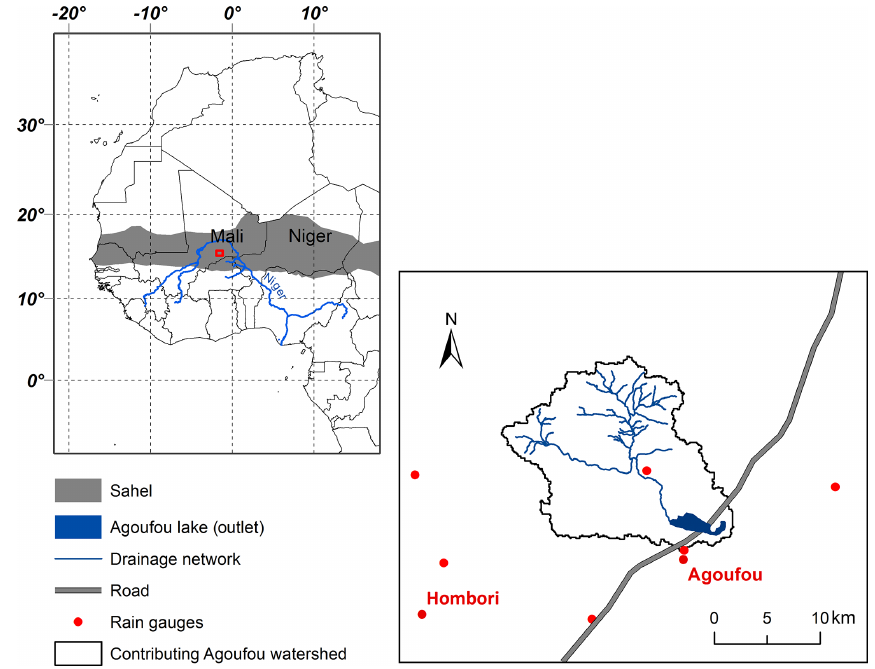
Figure 1. The Agoufou watershed (245km 2 ) located in western Sahel (Mali) with drainage network and available rain gauges (map source: